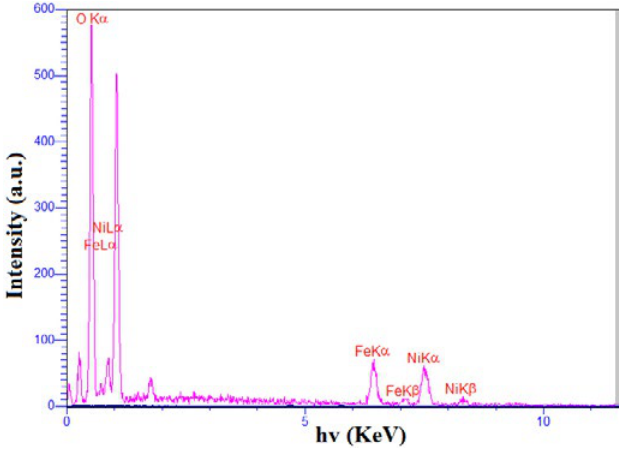
O and FNMMO. 3 4